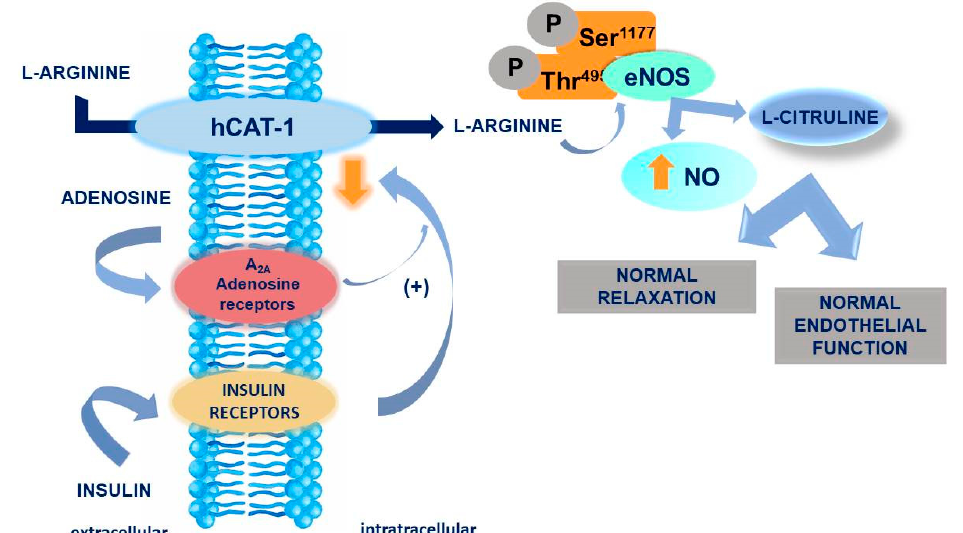
Figure 8. The role of L-arginine transport mediated by human cationic amino acid transporters 1 (hCAT-1) in nitric oxide (NO) and L-citrulline formation via endothelial NO synthase (eNOS). eNOS activity results from a balanced degree of phosphorylation of threonine 495 (P-Thr495) and serine 1177 (P-Ser1177).